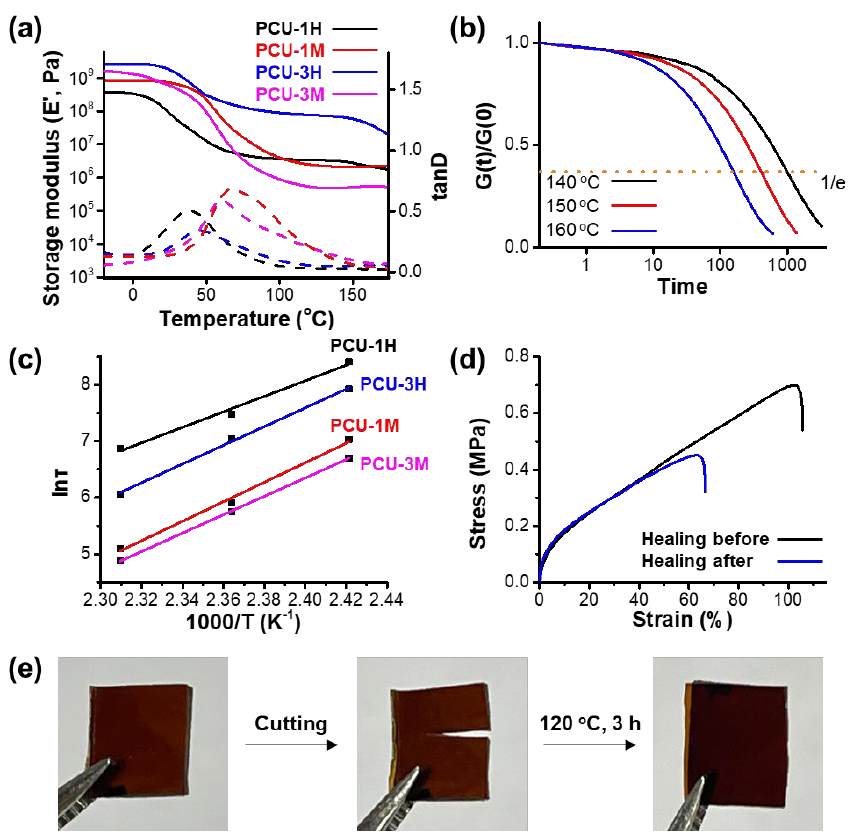
Figure 3. Thermomechanical properties of PCU films. ( a ) Tensile storage modulus and dissipation factor tan δ, measured using DMA from −20 o C to 180 o C under an N 2 atmosphere at a heating rate of 3 o C∙min −1 . ( b ) Normalized stress – relaxation curves as a function of time for three different isothermal temperatures from 140 o C to 160 o C. ( c ) Fitting of the relaxation times (τ) to the Arrhenius equation (see Supplementary Materials). ( d ) Tensile stress-strain curves before and after healing measured by UTM using the PCU-1M film. ( e ) Photographs showing thermal reparing of the cutted film of PCU-1M (120 o C, 3 h).